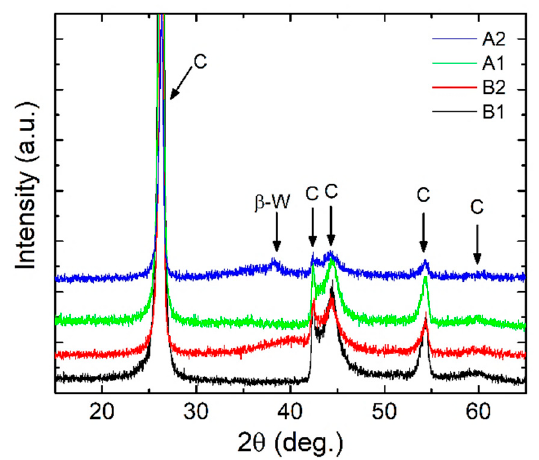
Figure 5. Diffractograms of magnetron sputtered layers: A1, A2, B1, and B2; notation C shows the XRD peaks of the graphite substrates.